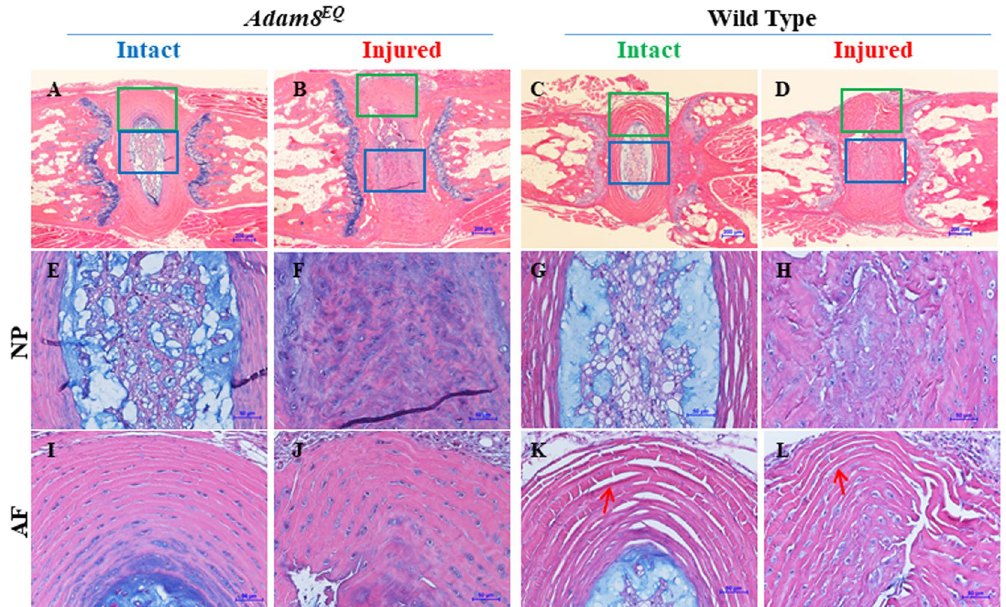
Figure 4. Alcian Blue staining demonstrating histologic changes including loss of proteoglycan in Adam8 EQ and wild type (WT) mice at 1 week after coccygeal intervertebral disc (IVD) injury. Intact and adjacent injured IVD were stained with Alcian blue; E through H and I through L are magnified images of blue and green outlined regions in A – D , respectively. AF annulus fibrosis, NP nucleus pulposus. Scale bars, 200 µm ( A – D ); 50 µm ( E – L